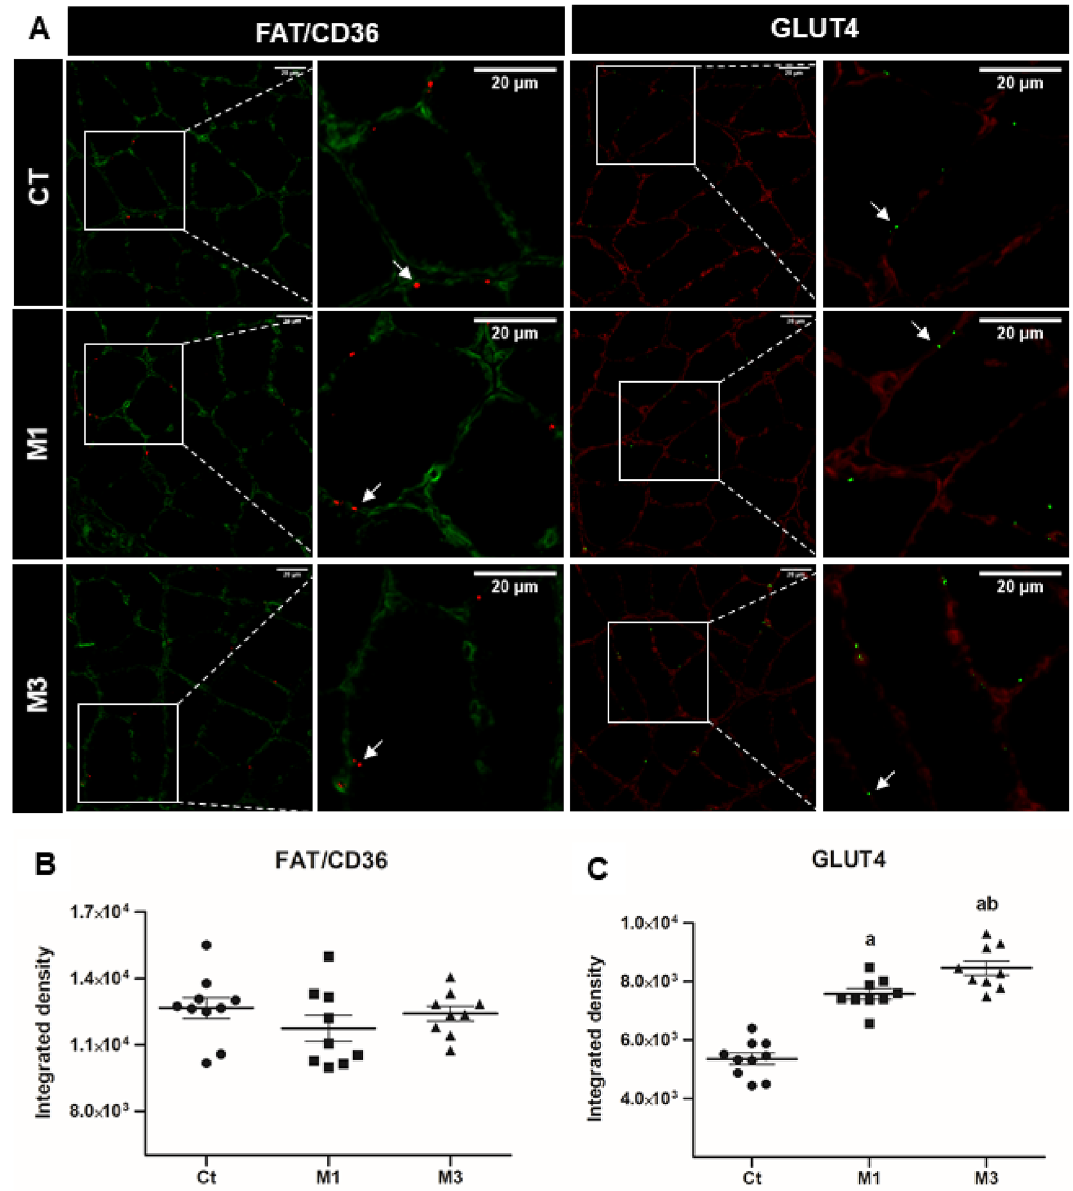
Figure 2. GLUT4 and FAT/CD36 in skeletal muscles. Representative samples of laminin (green) with FAT/ CD36 (red) in the soleus skeletal muscle with immunofluorescence ( A ). Representative samples of laminin (red) with GLUT4 (green) in the soleus skeletal muscle with immunofluorescence ( A ) in the control group (Ct) and rats treated with melatonin and euthanized 1 h (M1) or 3 h after the last procedures group (M3). The white arrows indicate FAT/CD36 and GLUT4 in the soleus skeletal muscle. The figures represent the means and standard errors of the FAT/CD36 ( B ) and of the GLUT4 ( C ). a p < 0.05 with respect to Ct; b p < 0.05 with respect to M1 for the same parameter. For the illustration, an objective lens = 20 × was used; bars = 20 µm; zoom = 300 height and 300